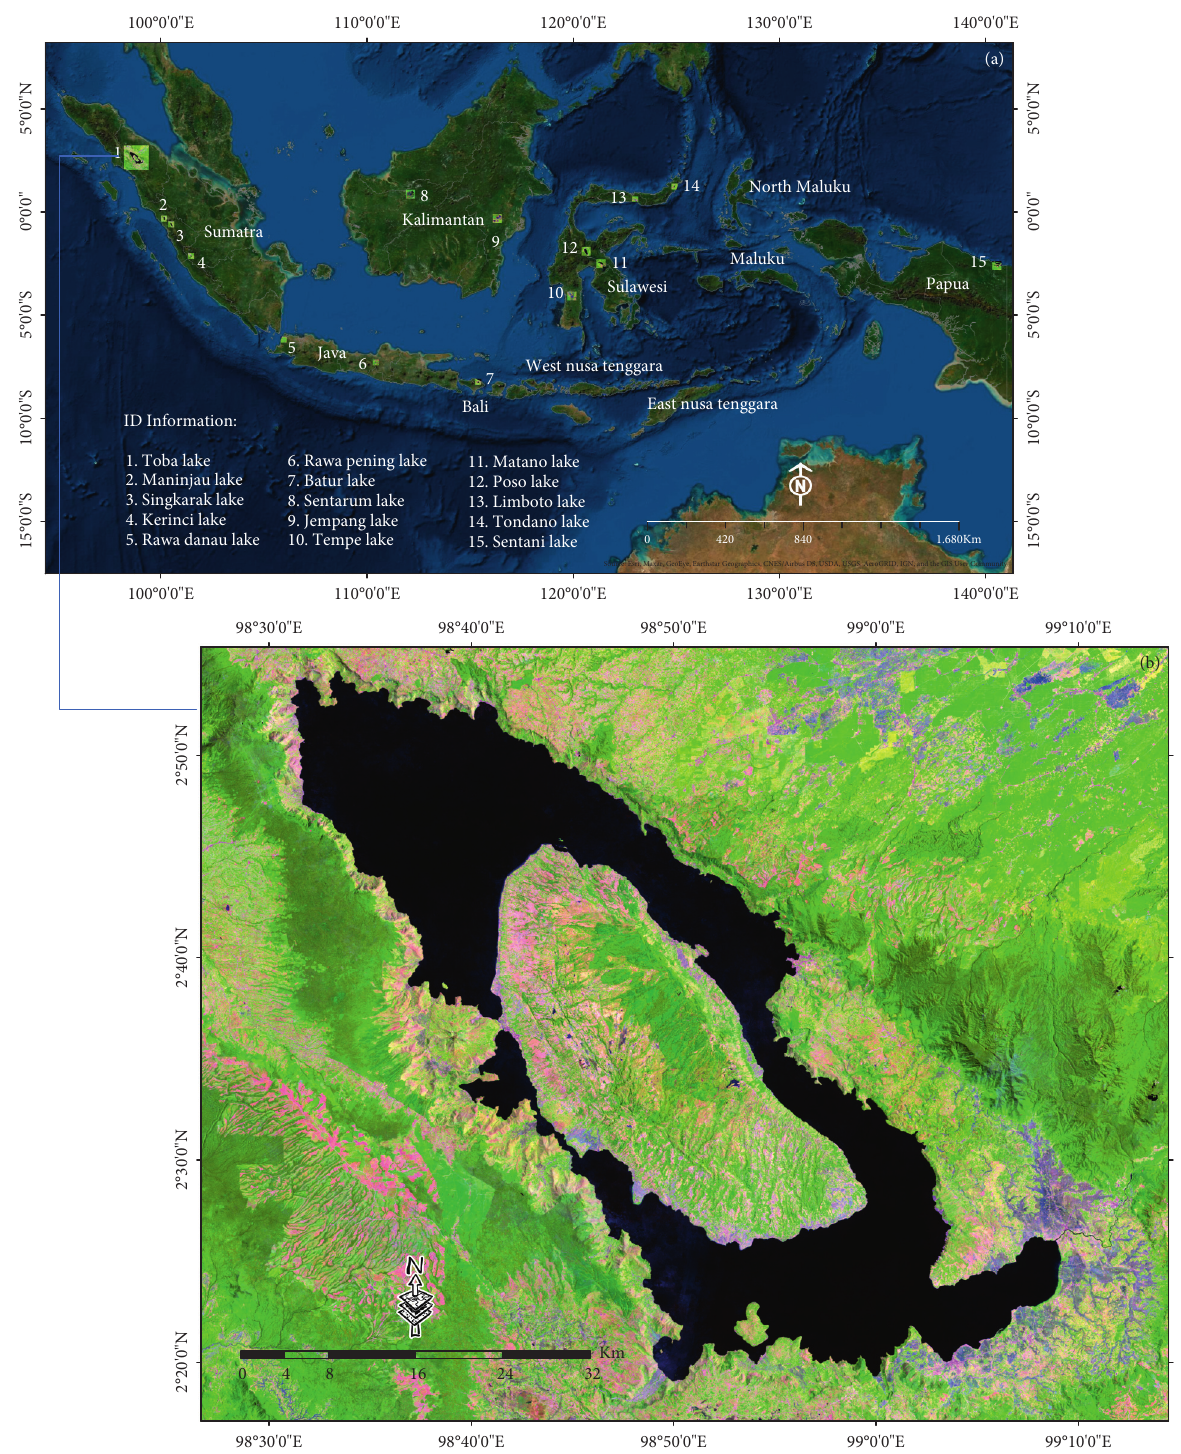
Figure 1: (a) Location of the 15 national priority lakes in Indonesia for management and spatial planning. At these locations, a test case study of AWEI threshold improvement was conducted, which represented the characteristics of other lakes. (b) Toba Lake, located in North Sumatra Province, Indonesia, was used as a test case study area to develop an AWEI threshold improvement model to detect lake surface water on remotely sensed optical